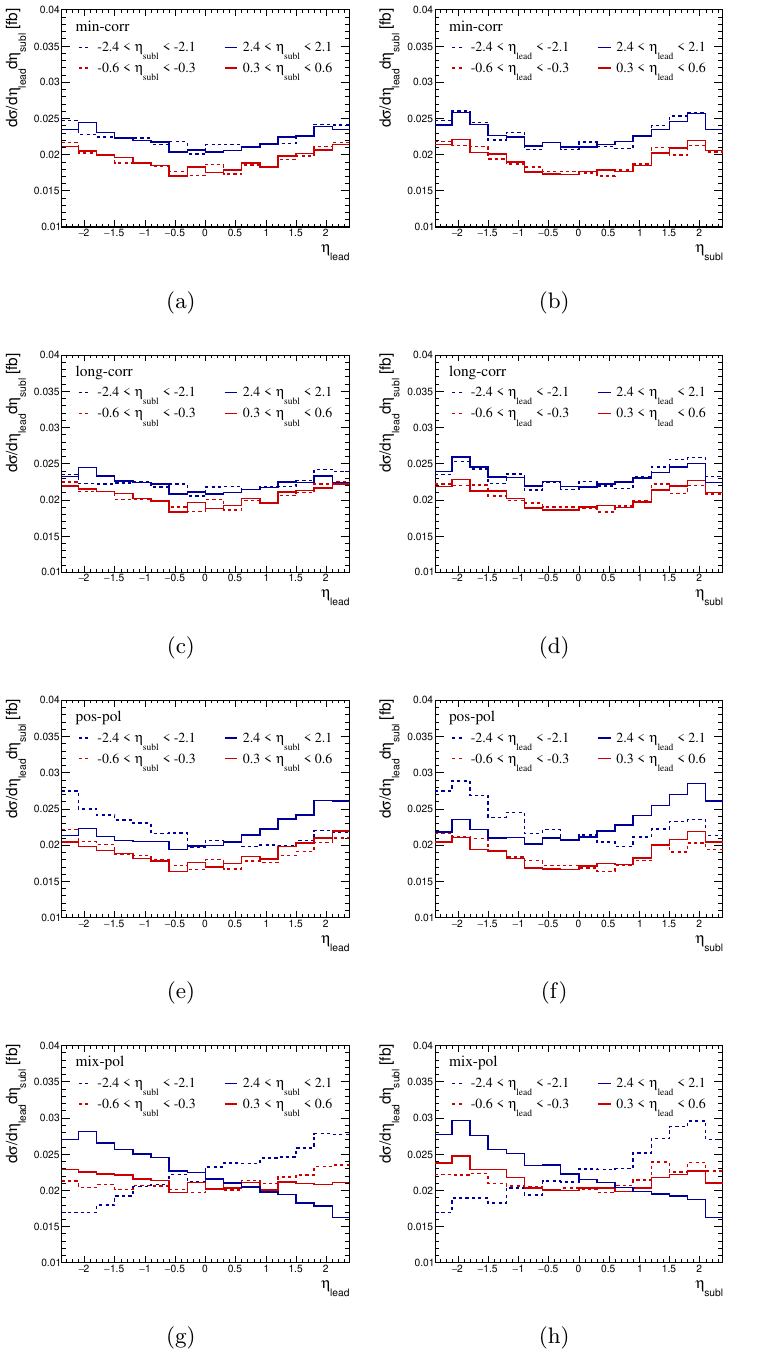
Figure 14 . Double-di(cid:11)erential distributions in rapidity of one of the muons (left: leading muon, right: subleading muon), for di(cid:11)erent ranges of the second muon rapidity separately for each cor- relation scenario, as indicated in the (cid:12)gures. Plots are similar to those in (cid:12)gure 4, here with HL muons within the phase space